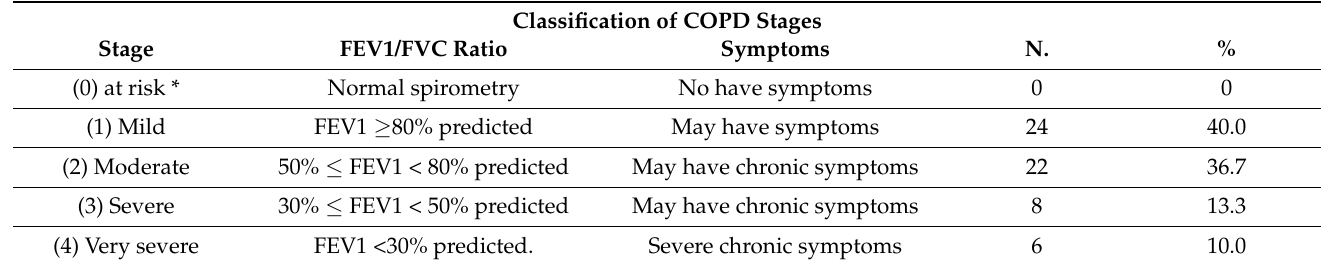
Table 3. Distribution of studied patients according to their COPD stages. (N = 60). Classification of COPD